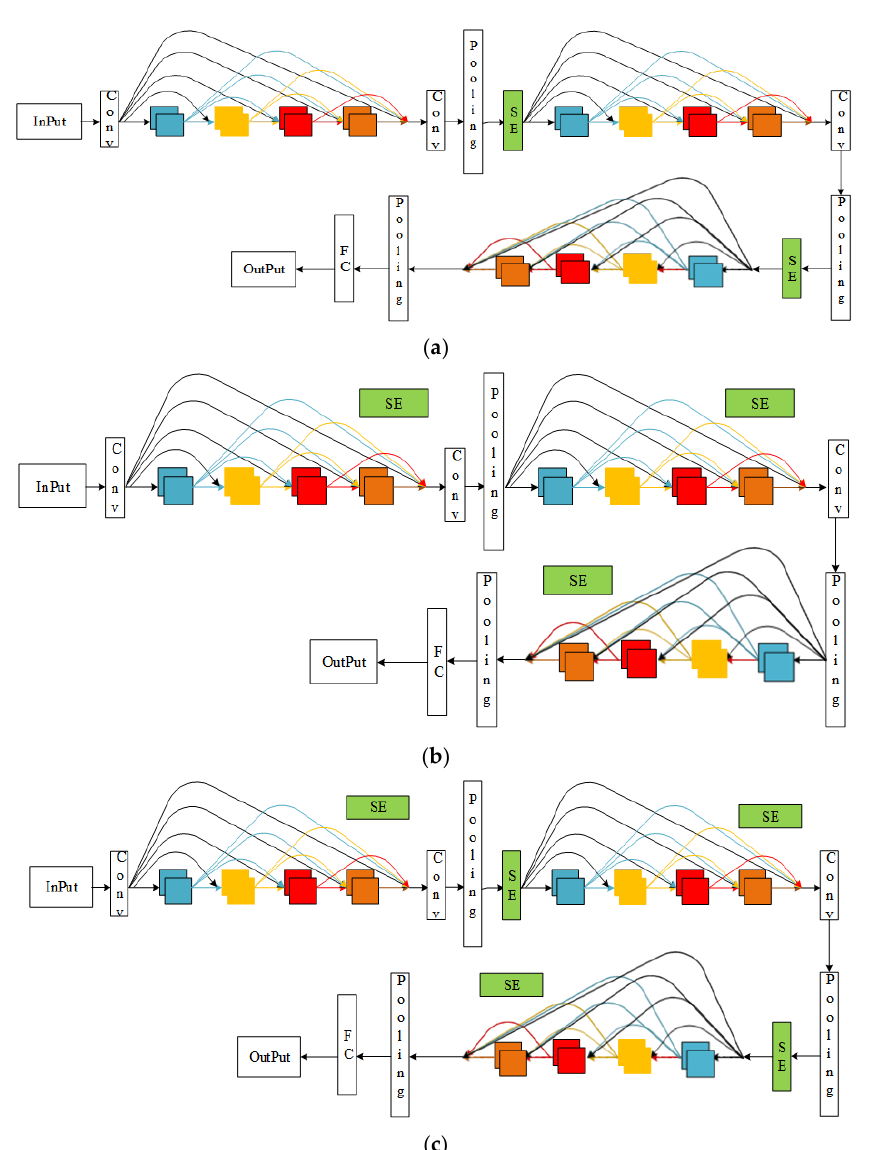
Figure 4. SE-DenseNet model architecture. ( a ) SE-DenseNet-1; ( b ) SE-DenseNet-2; ( c ) SE-DenseNet- 3.